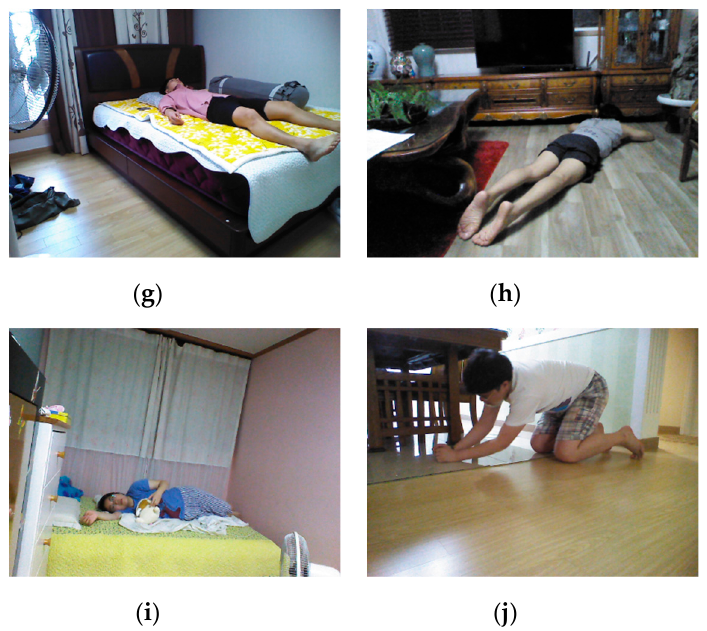
Figure 10. Examples of posture images captured from Astra camera in various home environments: ( a ) standing normal; ( b ) standing bent; ( c ) sitting sofa; ( d ) sitting chair; ( e ) sitting floor; ( f ) sitting squat; ( g ) lying face; ( h ) lying back; ( i ) lying side; ( j ) lying crouched.